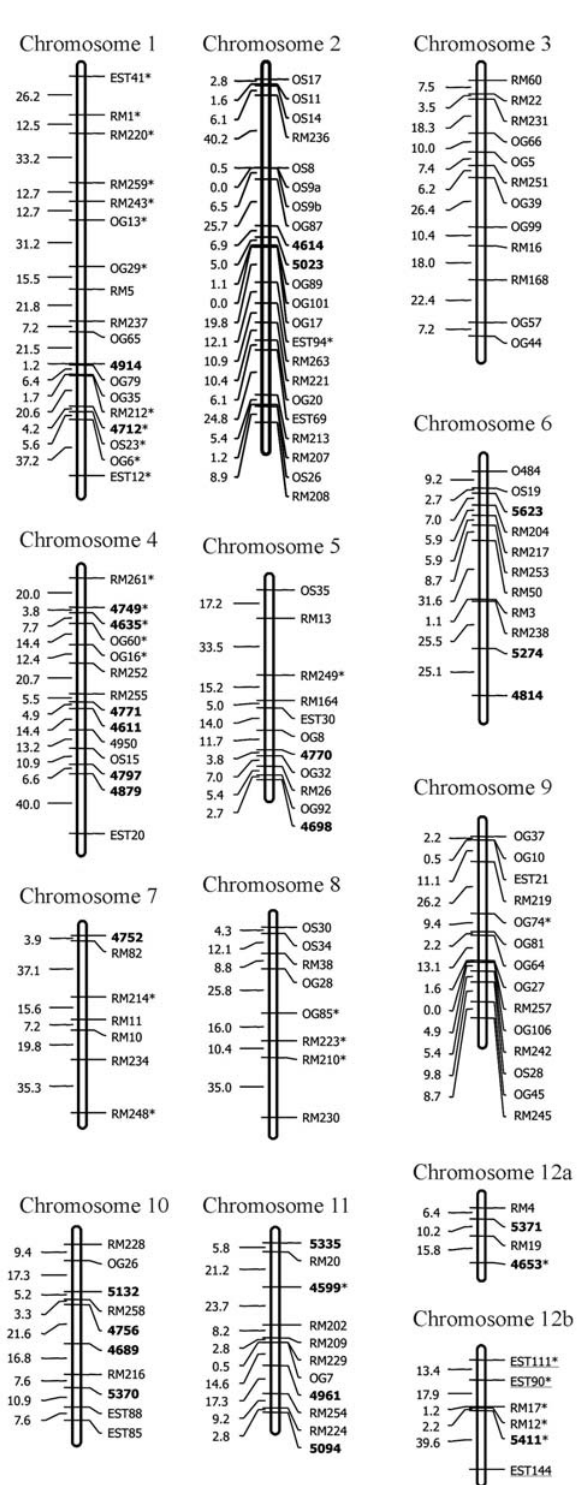
Figure 1 - Molecular linkage map of the Oyza glumaepatula x Oryza sativa interspecific population. Marker distances are expressed in centi- morgans. The Kosambi mapping function was used to adjust recombina- tion values. Distorted markers are indicated with an asterisk. Micro- satellite markers based on tri-nucleotide repeats derived from the GenBank database are in bold and expressed sequence tag (EST) markers are in italics. The EST-derived SNP markers are in italics and underlined. Marker O484 ( Waxy gene) is